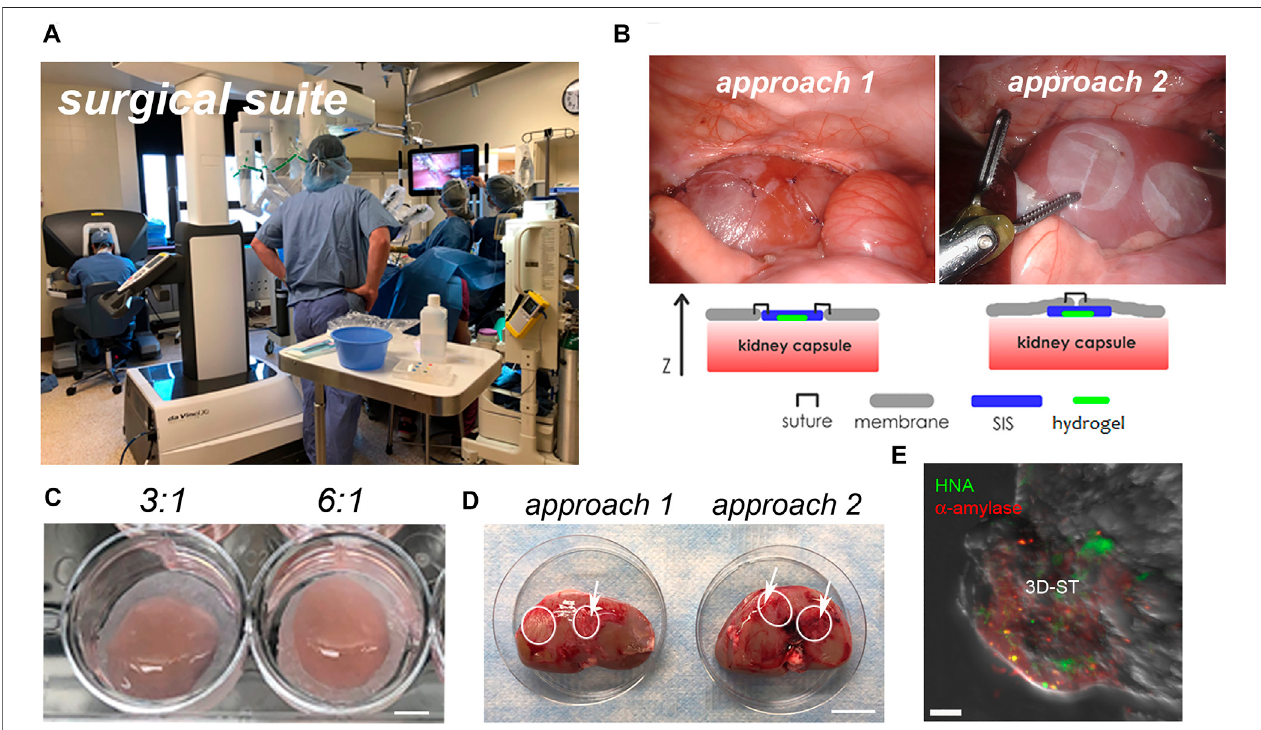
FIGURE 4 | Implantation of 3D-ST onto the renal capsule. (A) Surgical suite with the da Vinci surgical system; (B) two different approaches to test stitching of sutures;left,theSISmembraneissutureddirectlytotherenalcapsulemembrane;right,the3D-STisslidintopositionunderneaththemembraneoftherenalcapsuleand then the capsule membrane is re-stitched together over the 3D-ST. (C) In both cases, the hydrogel containing the encapsulated cells, visible on the DynaMatrix ® , faces downtowardthekidney;3:1and6:1refertotheratioofthiol – acrylate(SH-Ac)usedinthehydrogelformulationtocontrolstiffness;scalebar (cid:1) 0.5 cm. (D) Resected kidneysafter2 weeksofimplantshowing3D-STs(outlinedinwhite);revascularizationofimplant(whitearrows);scalebar (cid:1) 3 cm. (E) Identi fi cationoflivinghS/PCsin3D- ST on the resected renal capsule by testing for human α -amylase (red) and human nuclear antigen (green); scale bar (cid:1) 10